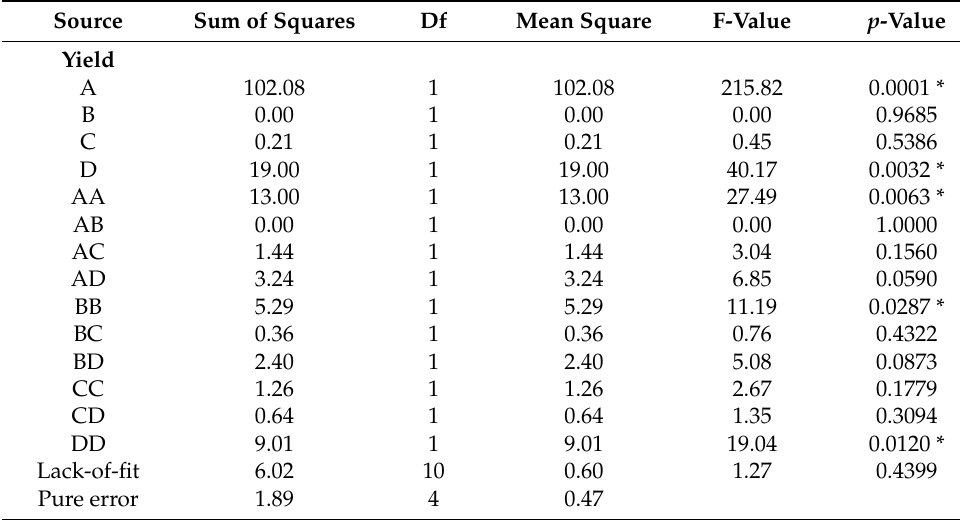
Table 3. ANOVA results for response surface quadratic models of AVS